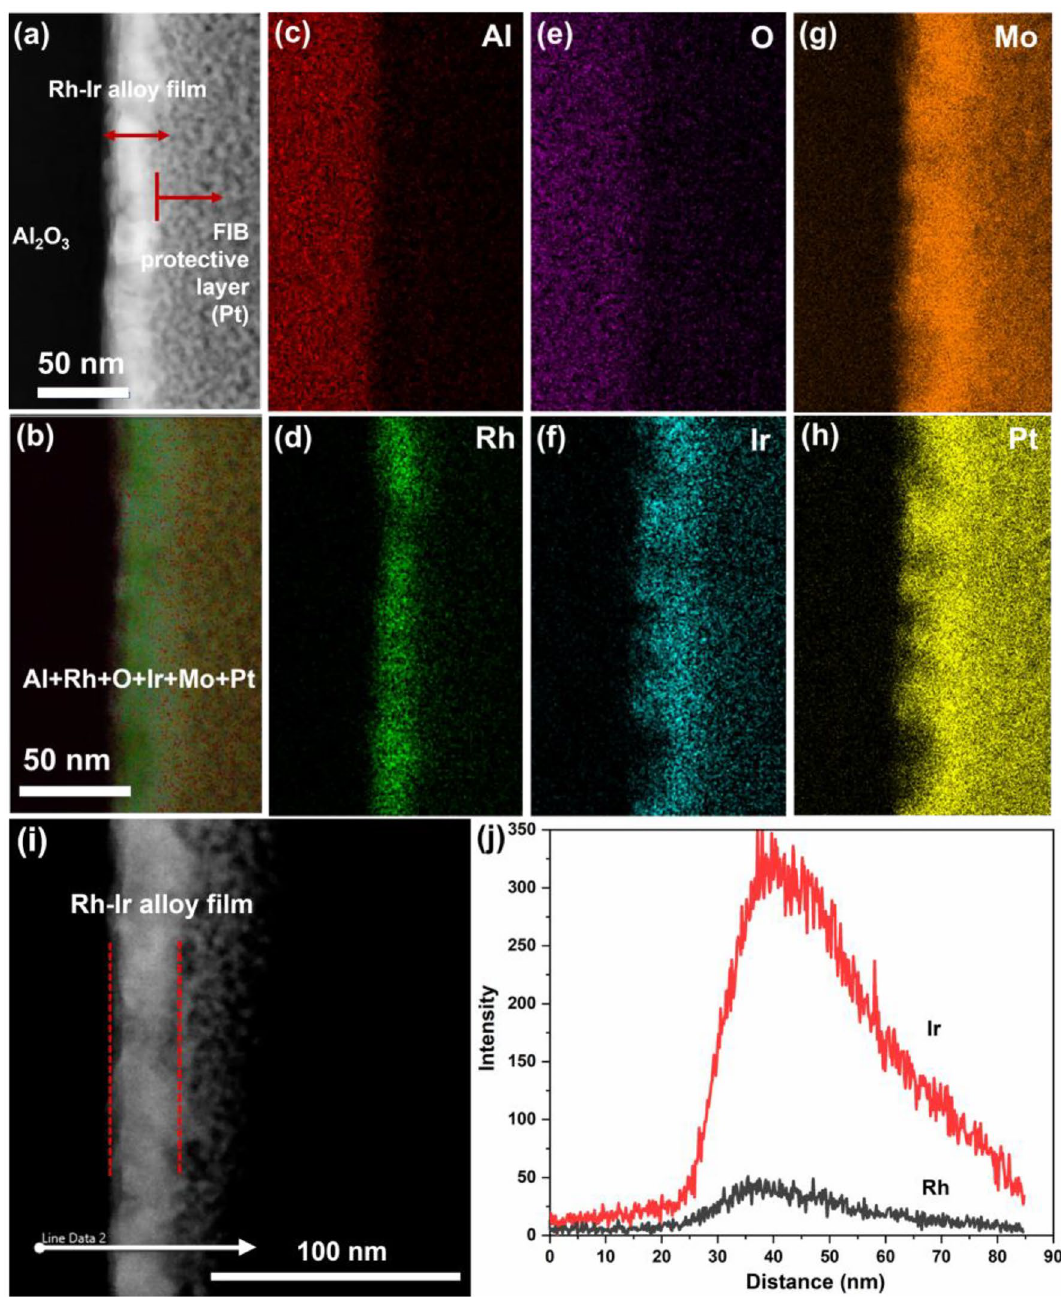
Figure 5. Cross-sectional TEM–EDX elemental mappings of the Rh–Ir alloy thin film. ( a ) Dark field STEM, ( b ) overlapping image, ( c ) Al k ⍺ 1, ( d ) Rh L ⍺ 1, ( e ) O K ⍺ 1, ( f ) Ir M ⍺ 1, ( g ) Mo L ⍺ 1, ( h ) Pt M ⍺ 1. ( i ) TEM image with a line indicating the EDX line scan position. ( j ) EDX line scan with Rh Kα and Ir Kα signals over a distance of 85 nm of the alloy thin point 1, 2 and 3) in the metal film with consistent atomic ratio of ~ 1.7 (Fig. 4b), while no Rh or Ir was observed in the Al 2 O 3 substrate region (points 4 and 5), confirming the diffusion of Rh and Ir. The TEM cross-section in Fig. 5a shows a uniformly and conformal Rh–Ir alloy thin film on the Al 2 O 3 sub- strate. The total thickness of the Rh–Ir alloy film was measured to be 30 nm, which is in good agreement with that measured by XRR. EDS in mapping mode was used to examine the alloy thin film, indicating that Rh and Ir were relatively well-distributed evenly without obvious evidence of segregation (Fig. 5b–h). From the STEM micrograph (Fig. 5a), we can observe some brightness variations across the film, which correspond to varying atomic weights. This shows that the alloying parameters have not been fully optimised to obtain full interdiffusion. As such, the EJH processing parameters would have to be studied and optimised to get complete interdiffusion. Nevertheless, it has been shown that alloying did take place to a significant degree.